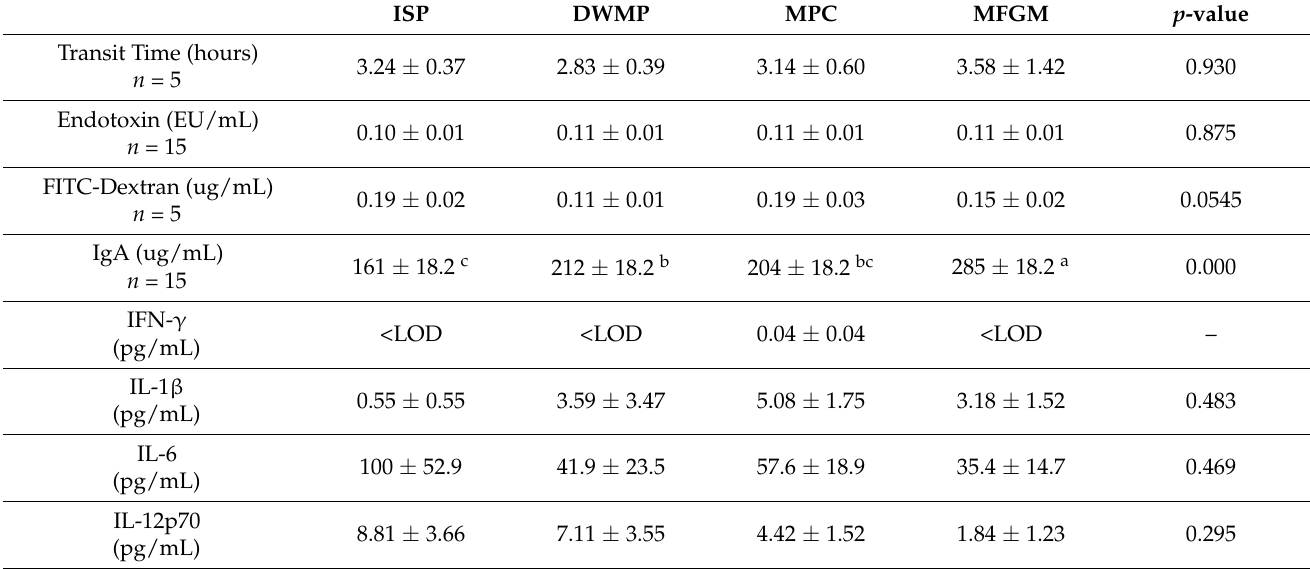
Table 4. Markers of gastrointestinal (GI) integrity and systemic inflammatory